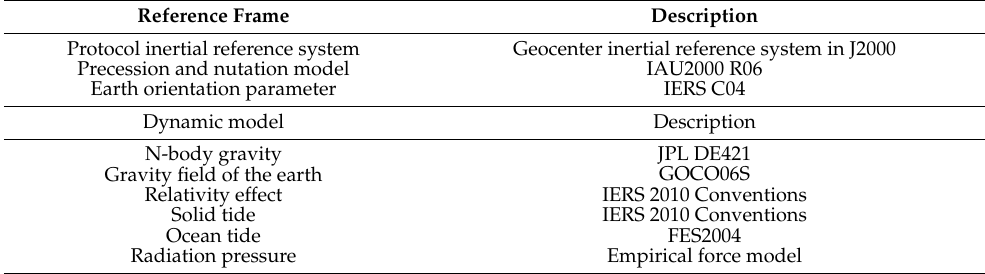
Table 3. Strategies for low earth orbit satelliteprecise orbit